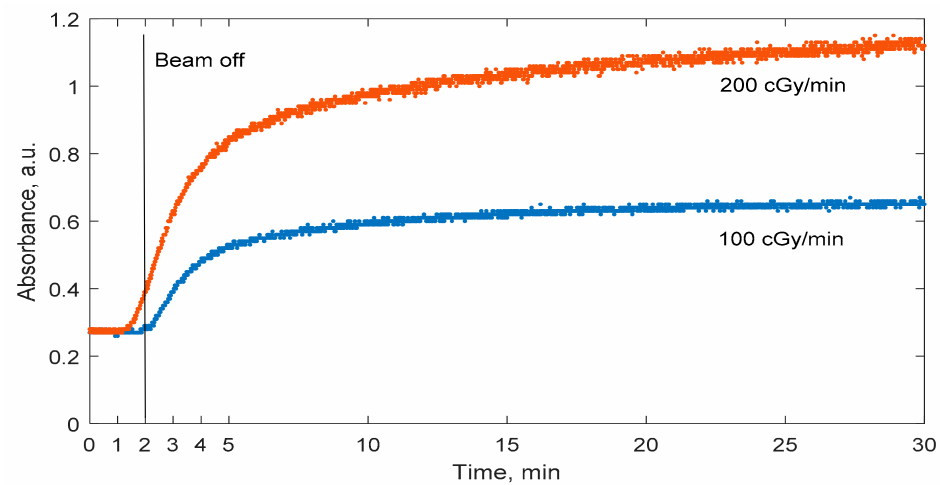
Figure 5. Temporal variations of the optical properties of nMAG gel dosimeter irradiated with different dose rates.